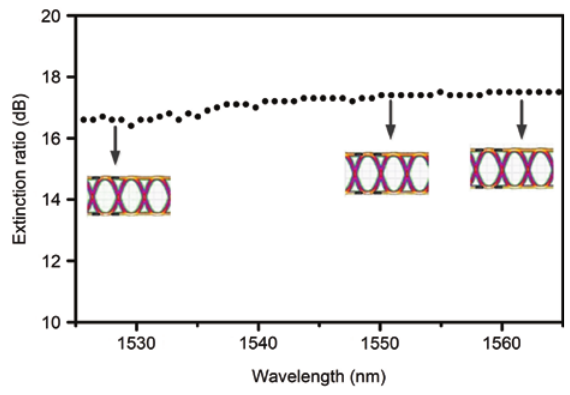
→ O of the six- 5 6